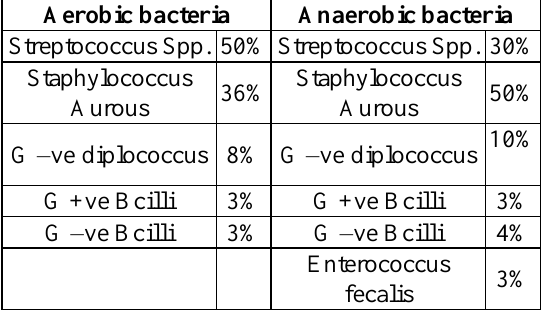
Table 4: The most common isolated aerobic and anaerobic bacteria in examined media /